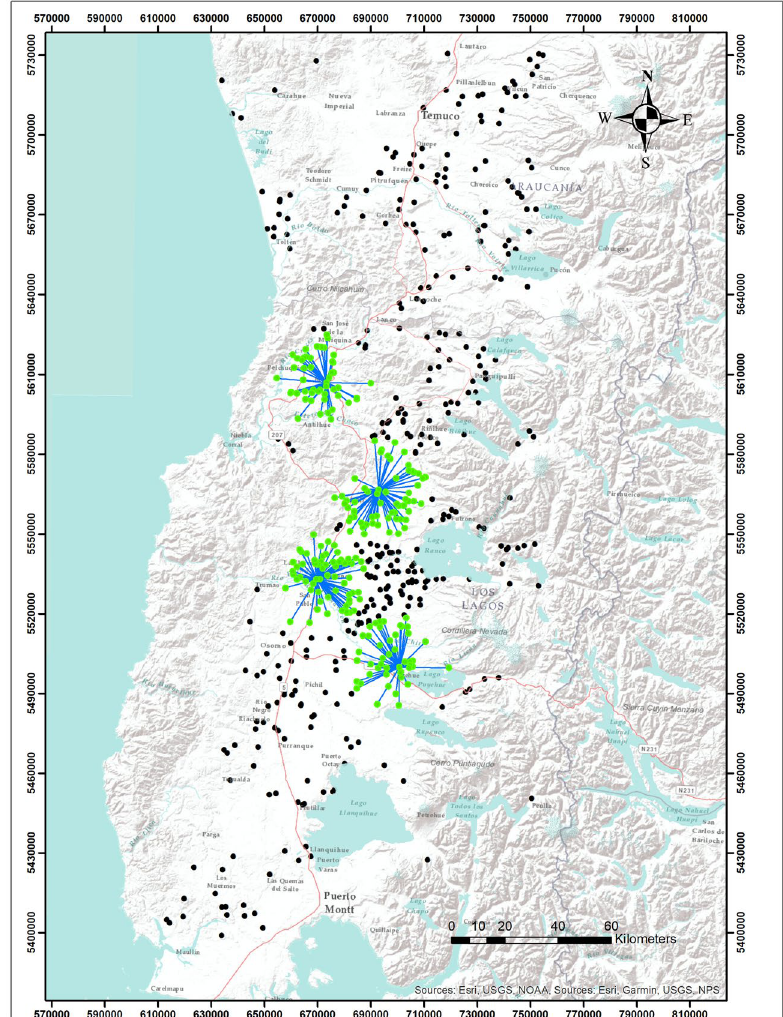
Fig. 5 Plant locations accord- ing ArcGIS Network Analyst with a maximum radius of up to 50 km, in the most profit- able